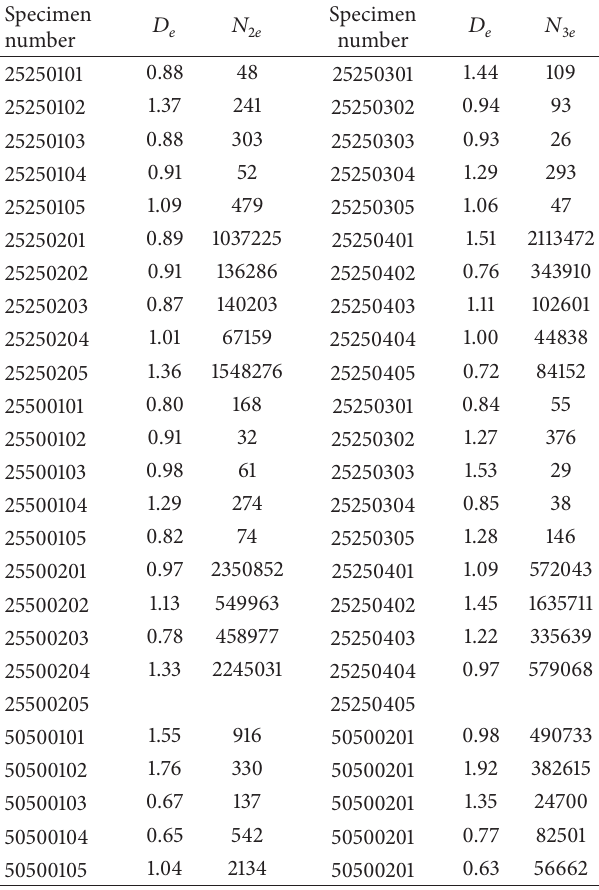
Table 4: Variable amplitude fatigue life of